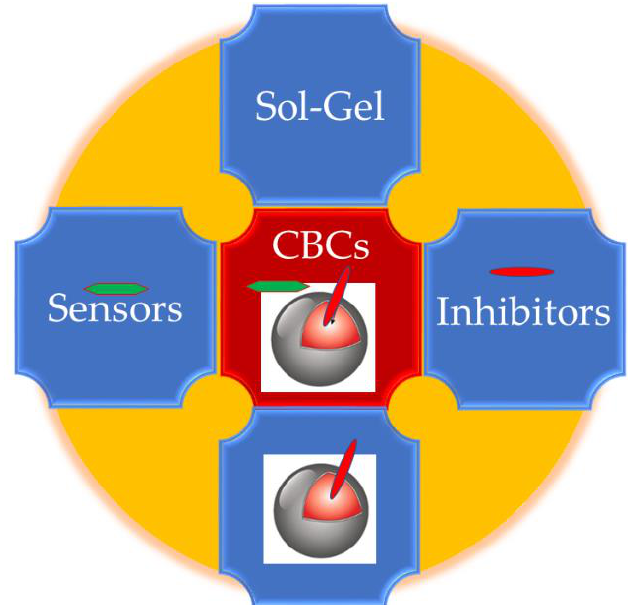
Figure 1. Schematic illustration of the steps taken to replace chromium (VI) CBC with ecofriendly CBC exhibiting the self-healing phenomenon.